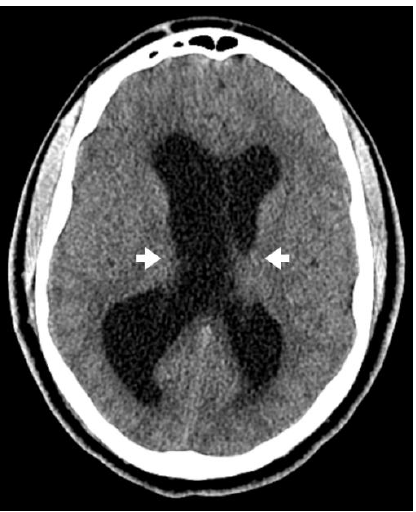
Image 1. Axial computed tomography revealing enlarged lateral ventricles (white arrows) and hydrocephalus. No dilation of third or fourth ventricles or definitive signs of herniation were